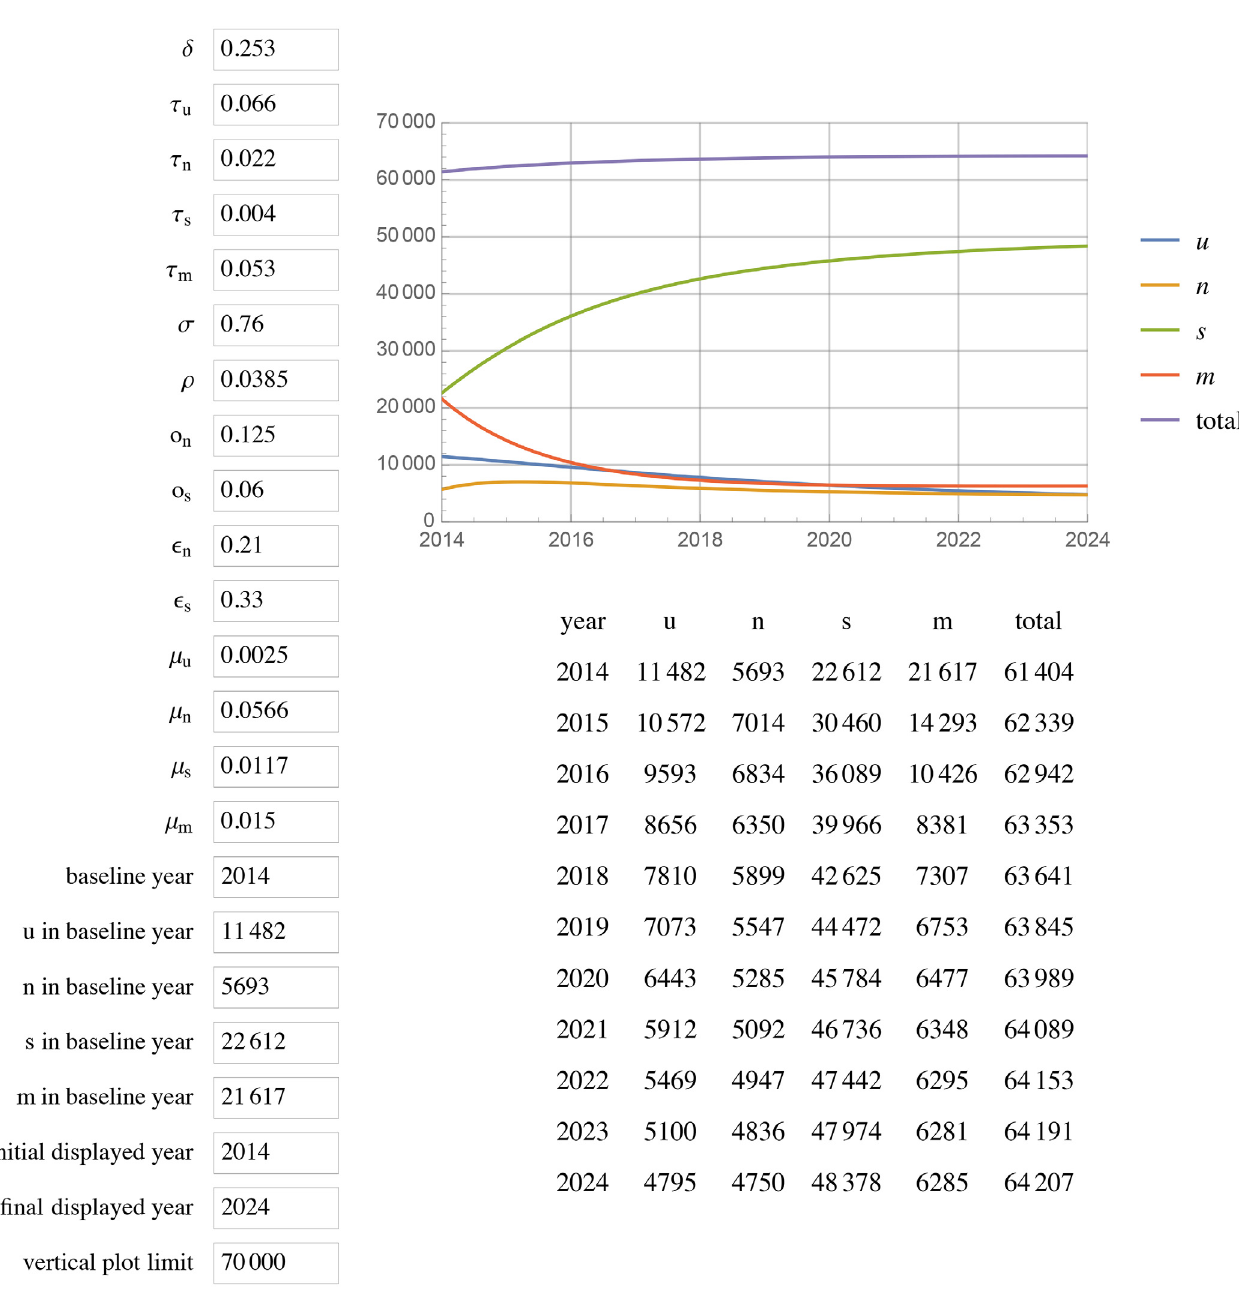
Fig 5. HIV prevalence projections with multiple